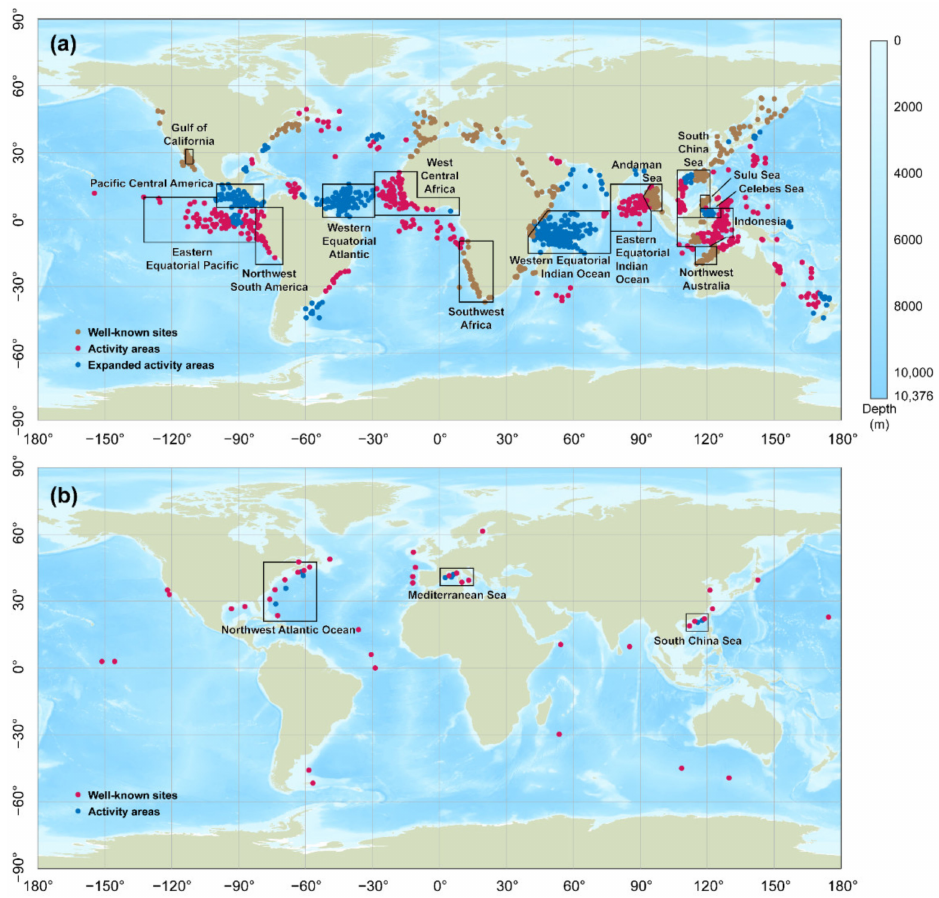
Figure 1. Nonlinear internal wave and nepheloid layer distribution around the world. ( a ) Global internal waves observed in MODIS imagery from 2002 through 2004, adapted from Jackson [13]. ( b ) Global nepheloid layers observed from 1953 through 2019, adapted from Tian et al. [14]. The well-known sites are regions where internal waves or nepheloid layers have been previously reported and their characteristics well-documented. The activity areas are regions where internal wave or nepheloid layer activity has been reported but their characteristics have not been determined. The expanded activity areas are regions in which the MODIS survey found a significant amount of internal wave activity where little or no activity had been previously